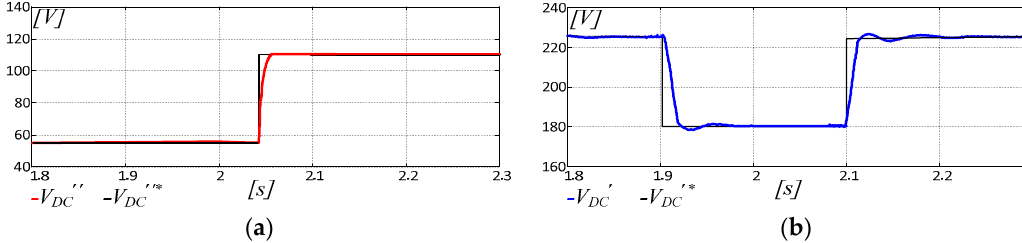
Figure 18. Averaged-value model. One-time variation of V DC ' and V DC '' references. (a) TLI DC bus voltage V DC ''. ( b ) Output voltage V DC ' .